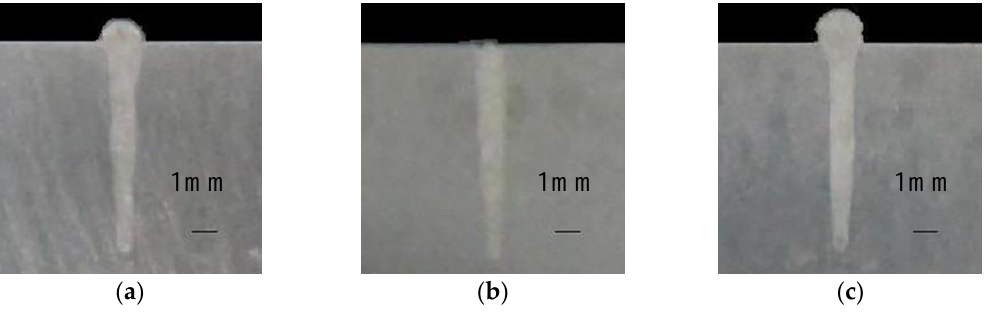
Figure 5. The traditional cross sections of the welded seam: ( a ) corresponding to region A; ( b ) corresponding to region B; ( c ) corresponding to region C. Table 2. The depth and the depth-to-width ratio of the three traditional cross sections. Region